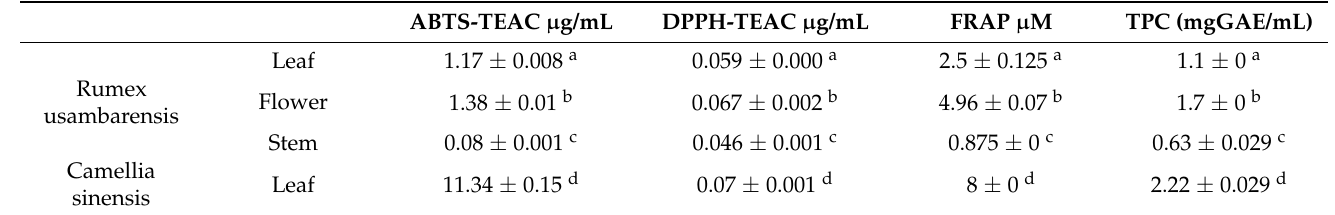
Table 2. Antioxidant activities of stems, leaves, and flowers of Rumex usambarensis and green tea leaves hydroalcoholic extract. Data are expressed as mean ± SD of three